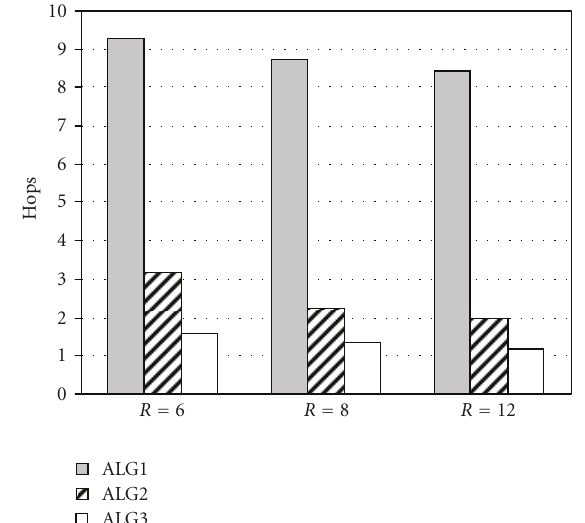
Figure 6: Average number of hops to get one proxy for a scenario with low connectivity ( τ = 4; ω = 50; P actual = 30%).